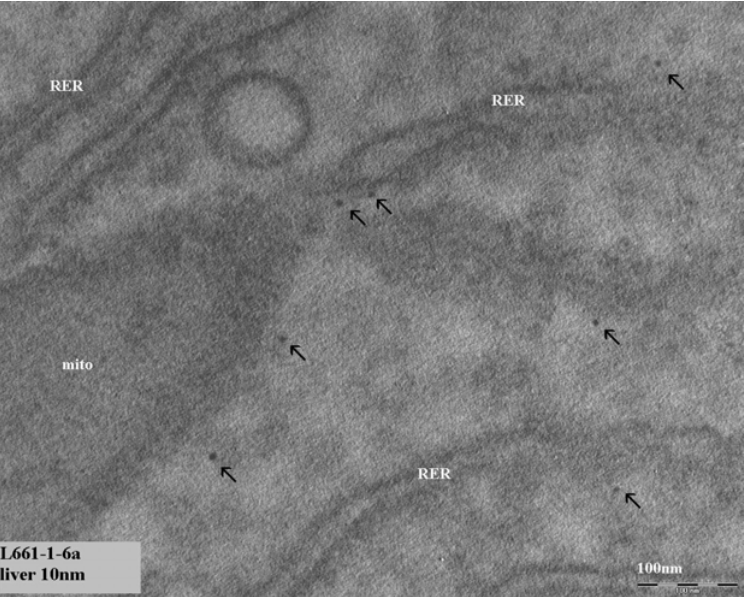
Figure 3. Presence of structures in the cytoplasm of liver cells. Arrows indicate nanosized (8–10 nm) structures in cytoplasm of cells. The marker indicates 100